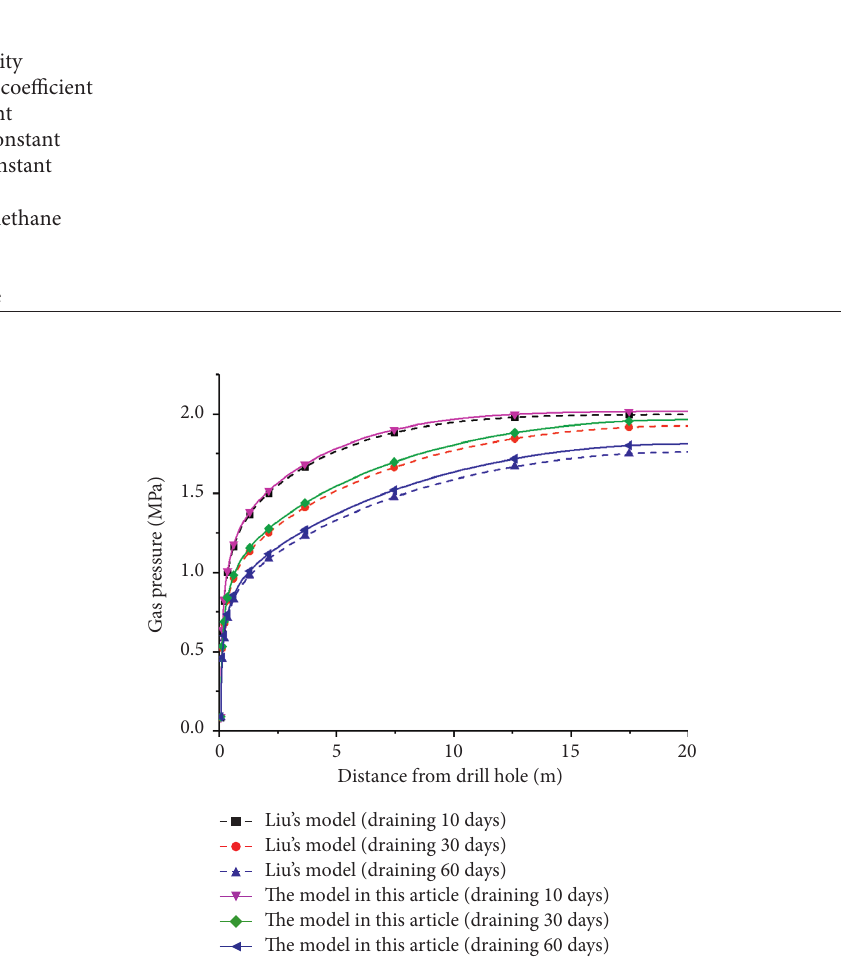
Figure 4: Data comparison between the model in this article and Liu’s model at different extraction times.